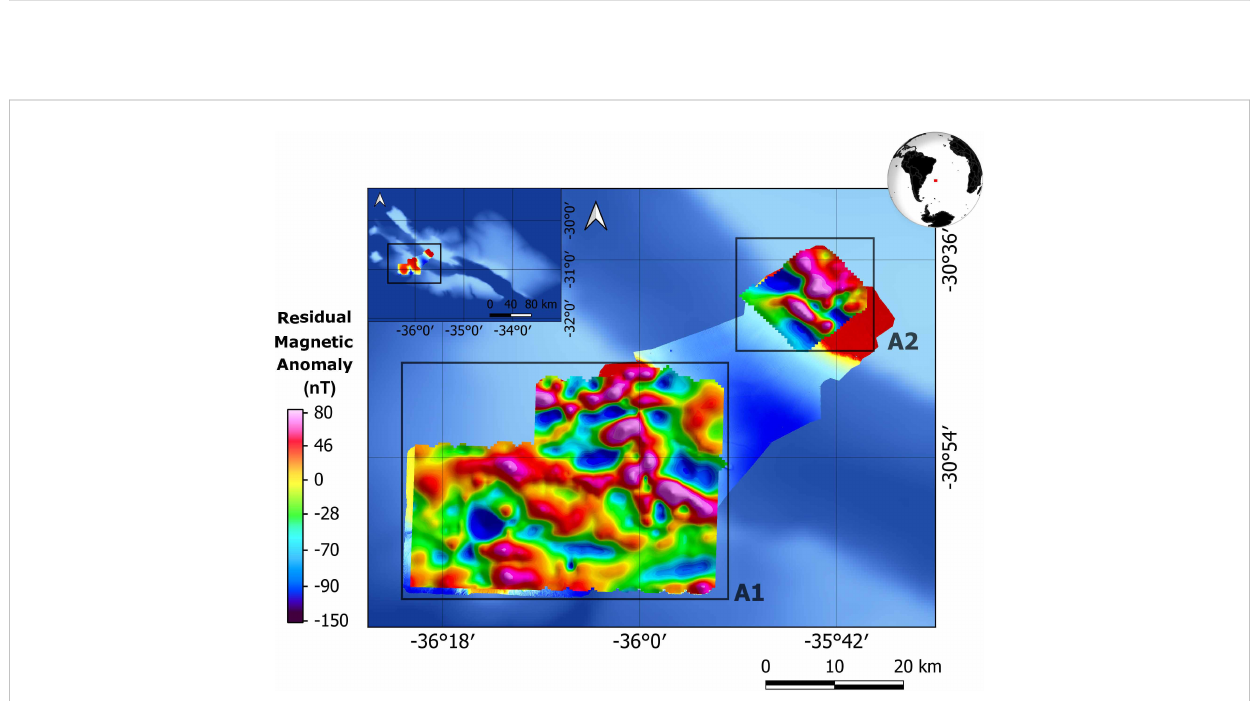
FIGURE 8 Residual Magnetic Anomaly map obtained after the Gaussian fi lter application in the areas A1 and A2, using a standard deviation of 0.0778 and 0,089, respectively. The grid cell size is 450